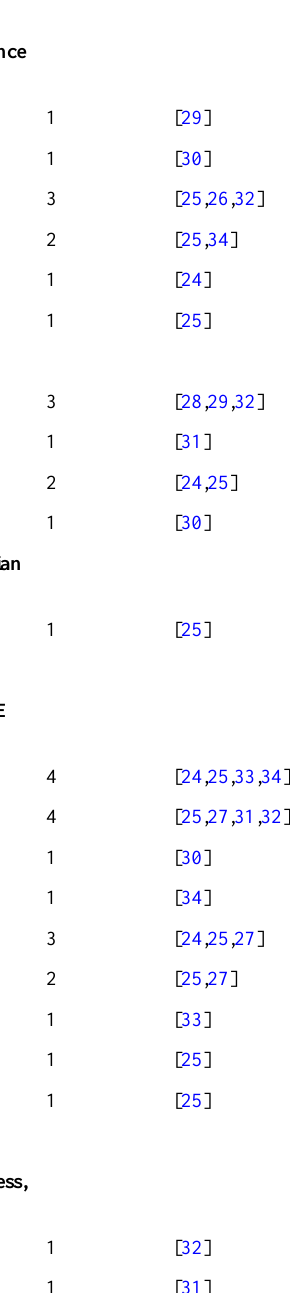
Table 1. Factors influencing the frequency of use of the computerized physician order entry system by physicians. Individual